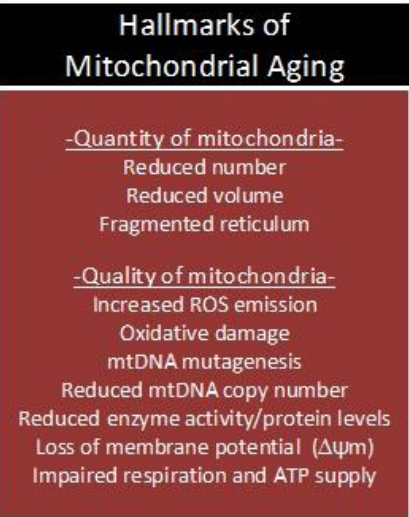
Figure 3. Age-associated deterioration in ‘quantity and quality’ of mitochondria. ROS: reactive oxygen species; mtDNA: mitochondrial DNA; ∆Ψ m : mitochondrial membrane potential; ATP: adenosine triphosphate